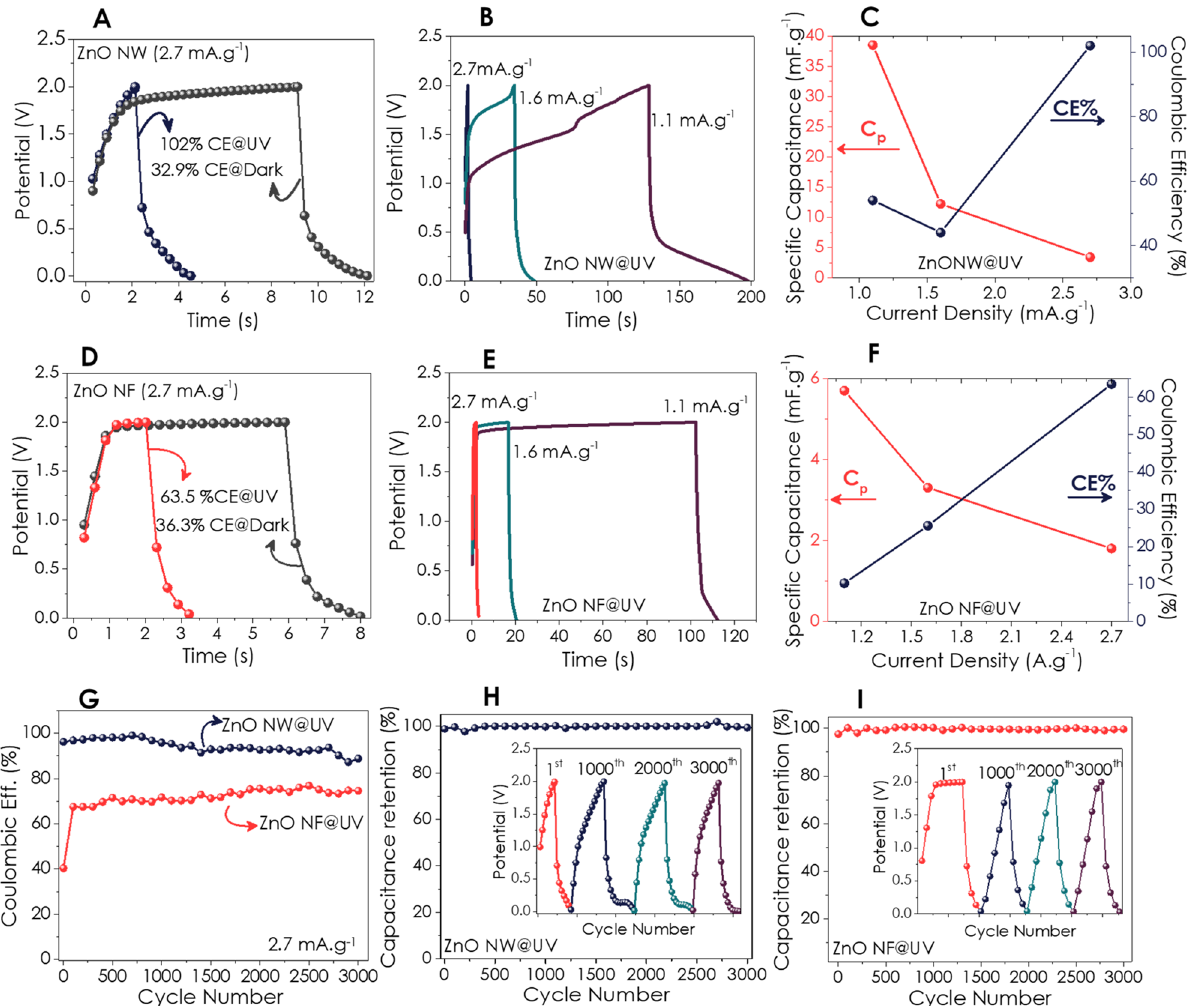
Figure 5. GCD curves; ( A ) comparison for ZnO NW under UV light and dark conditions at a 2.7 mA g −1 current density, ( B ) depending on changing current density under UV illumination, ( C ) capacitance and Coulombic efficiency, ( D ) comparison for ZnO NF under UV light and dark condition at 2.7 mA g −1 current density, ( E ) depending on changing current density under UV illumination, ( F ) capacitance and Coulombic efficiency, ( G ) Coulombic efficiency retention for 3000 cycles GCD under UV illumination. Capacitance retention and 1st, 1000th, 2000th and 3000th charge–discharge cycles (inset figure) for ( H ) ZnO NW and ( I) ZnO